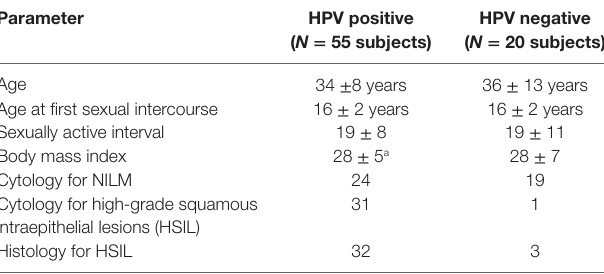
TaBle 1 | Summary of subjects, their attributes, and results for cytology, human papilloma virus (HPV) screening, and histology procedures. Parameter hPV positive